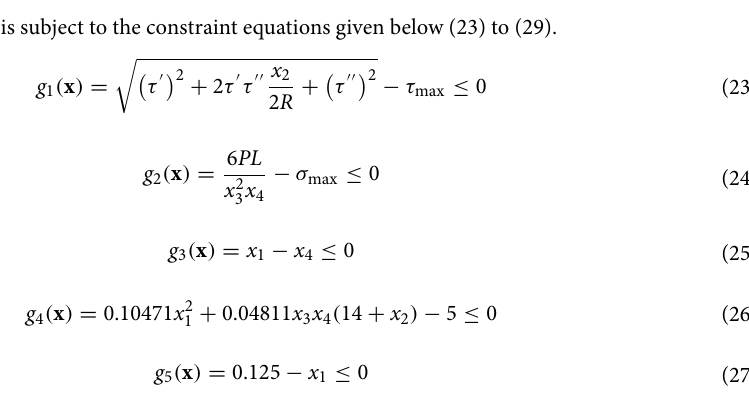
landscapes with several local extremums and steep, long, narrow valleys. CS improving variety in the population are the primary factors in AEFA-CSR’s success. Welded beam design problem. As a further validation of the performance of AEFA-CSR in real world optimiza- tion problem a well-known problem is chosen which is the welded beam design problem who was formulated by Rao 74 and used in CEC 2020 test function suite 75 . The welded beam design problem has several design param- eters as outlined in 55 . There are four design variables that need to be determined x 1 , x 2 , x 3 and x 4 . Under specific restrictions, the objective of WBD optimization is to reduce the overall cost. The restrictions are the buckling critical load PC , the bending stress σ , the shear stress τ , beam deflection δ and the tail of the beam. The following are the objective function and constraints. The objective function which needs to be minimized is given below in Eq. (22).